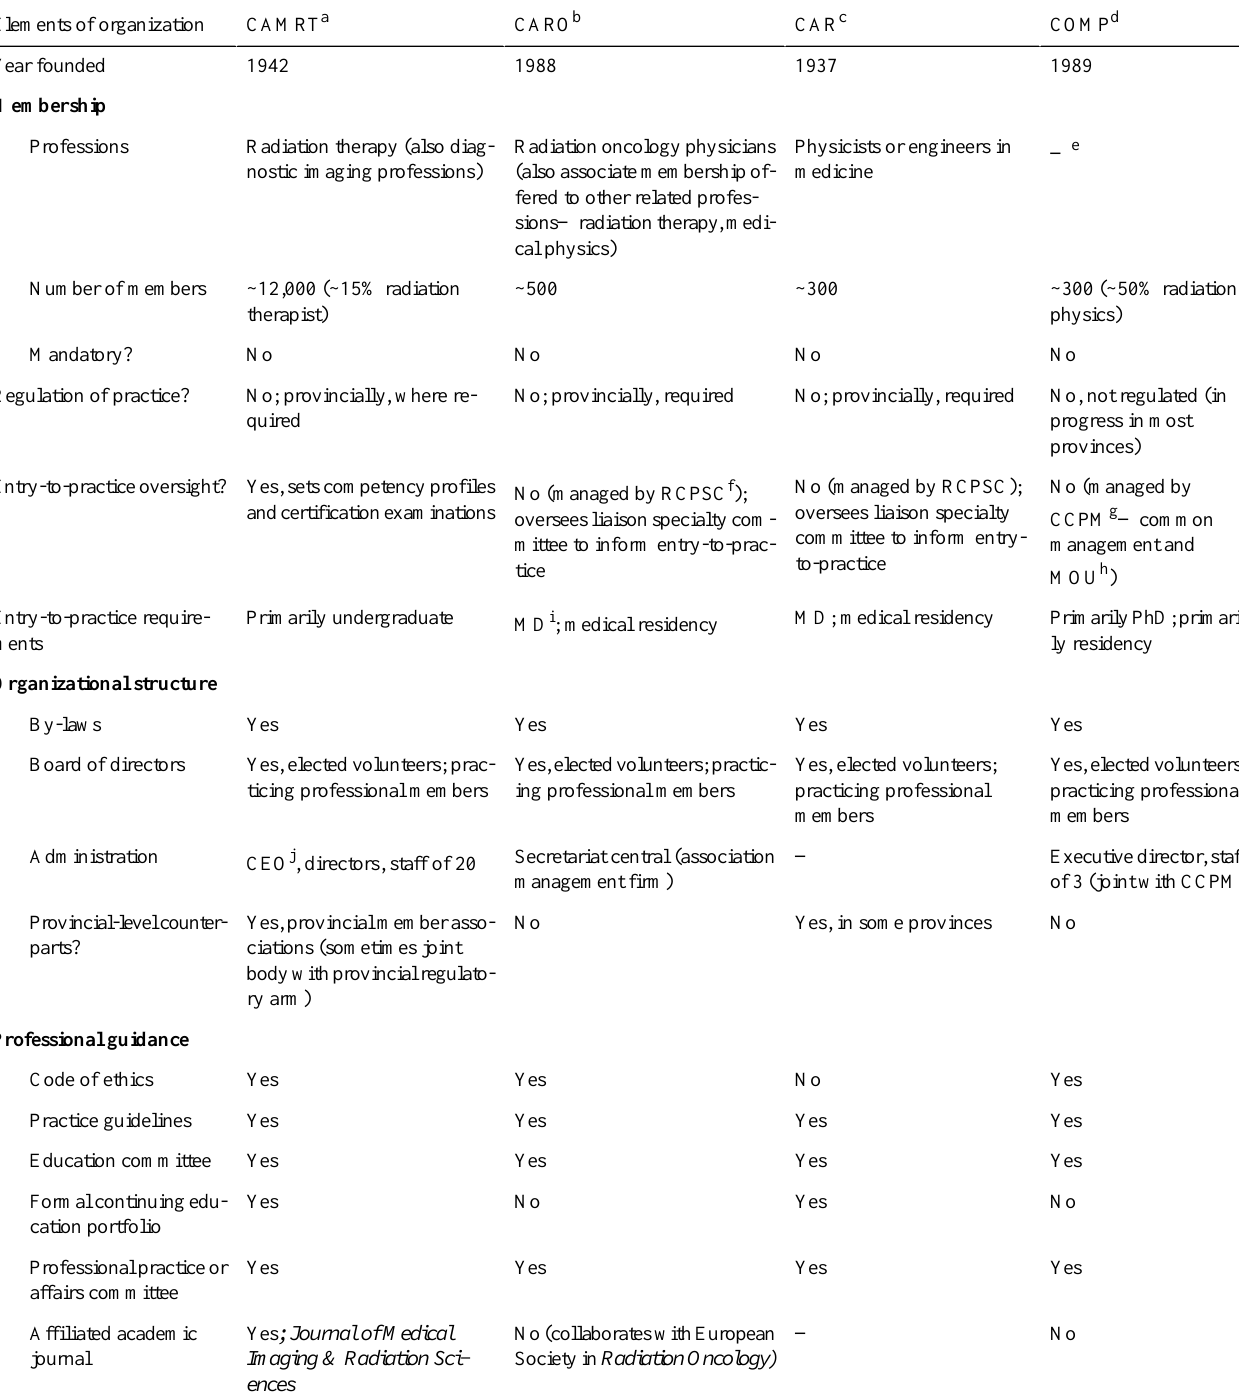
Table 1. Case logic